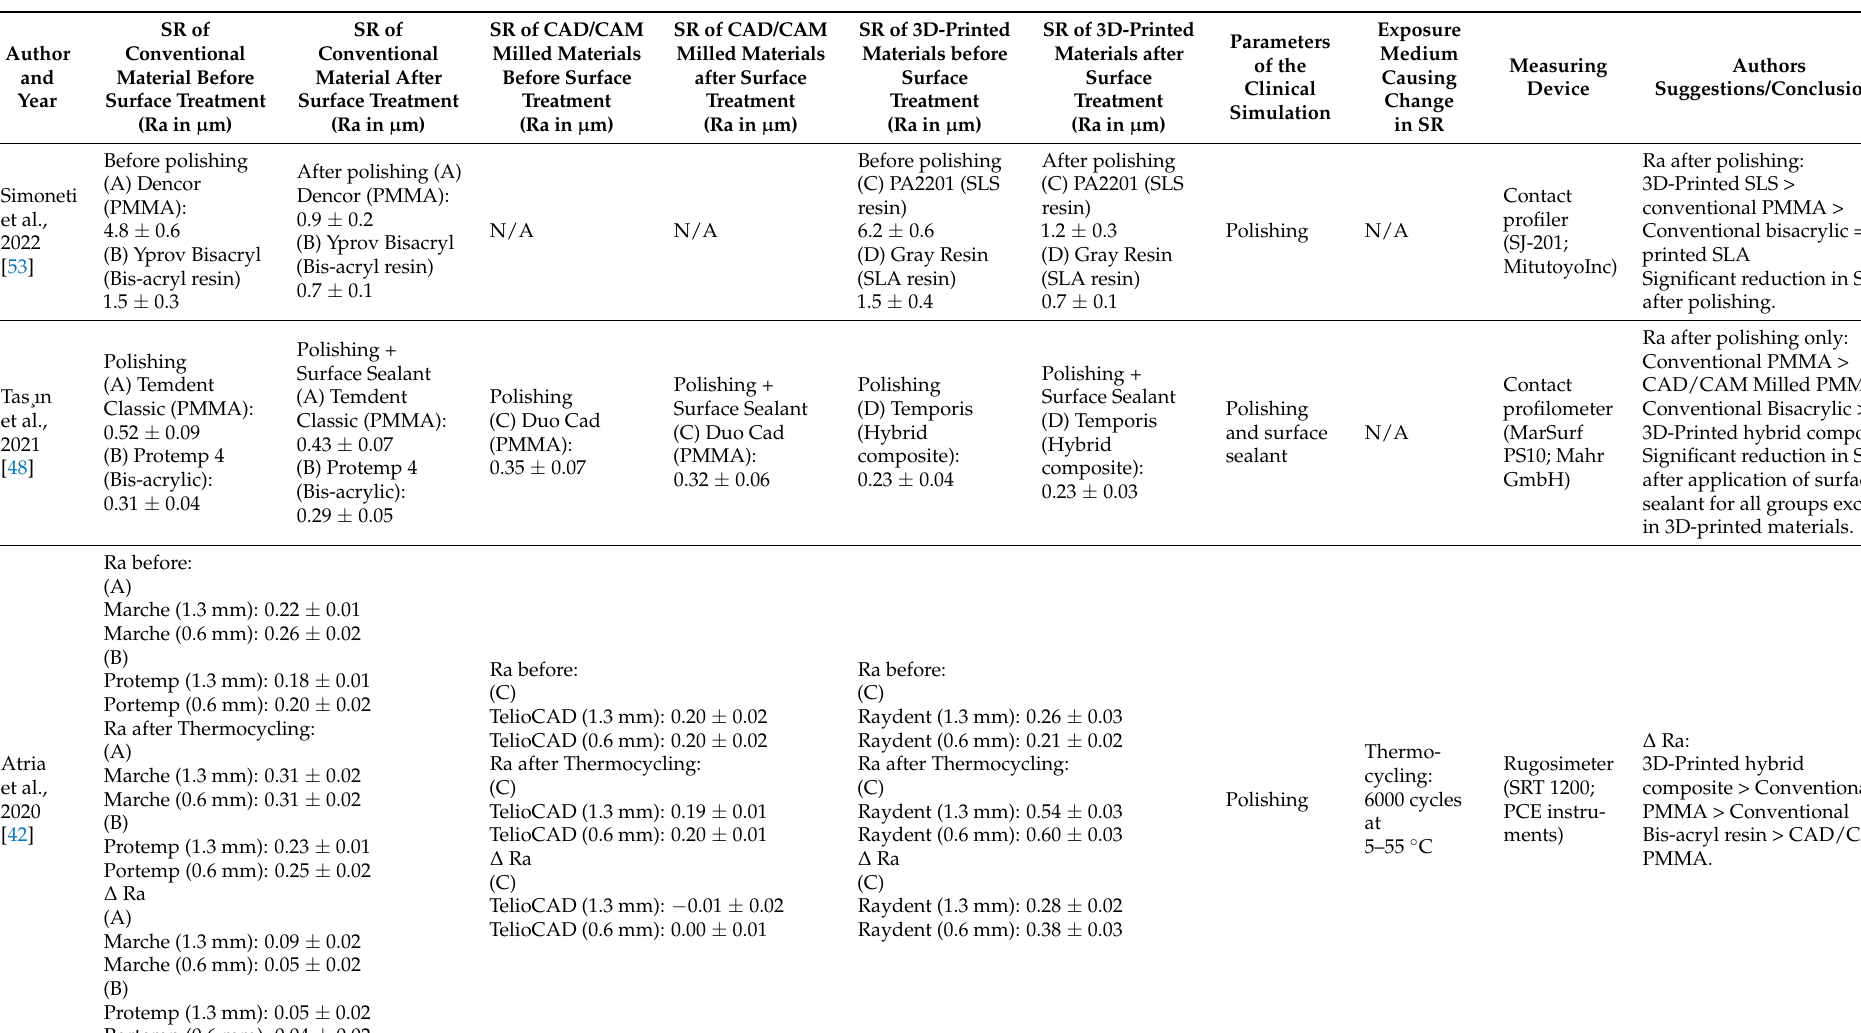
Table 9. Surface roughness (SR) test